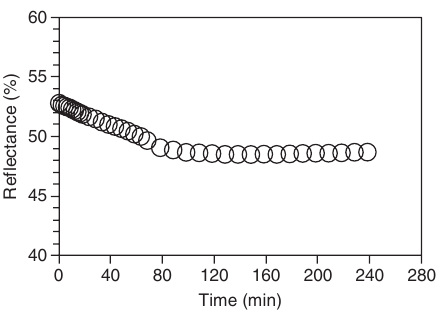
Figure 5 Back-scattering measurements of the MMA/BA/AA (49.5:49.5:1 wt%) miniemulsion containing PI-2 , reflecting its physical